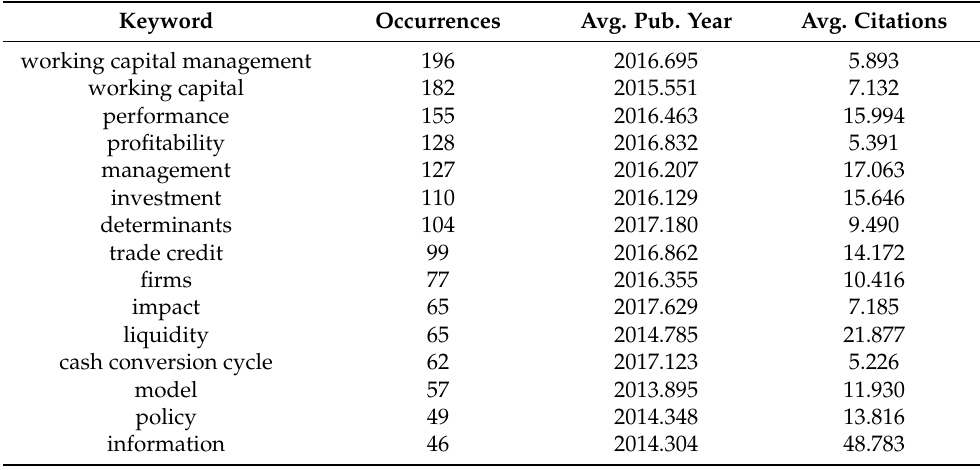
Table 1. Co-occurrence links and top 15 (occurrences) all keyword items, considering 1 as the minimum number of occurrences of a keyword and 1000 as the number of keywords